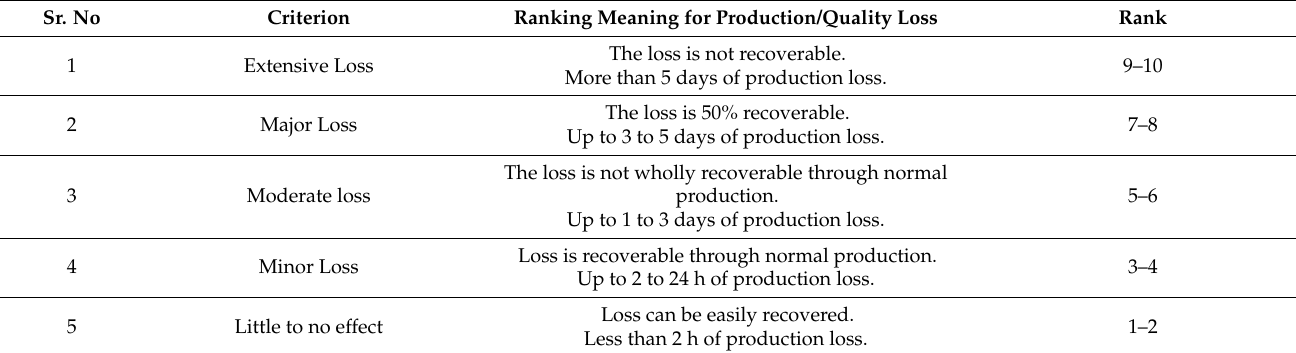
Table 6. FMECA scale to rate production/quality loss